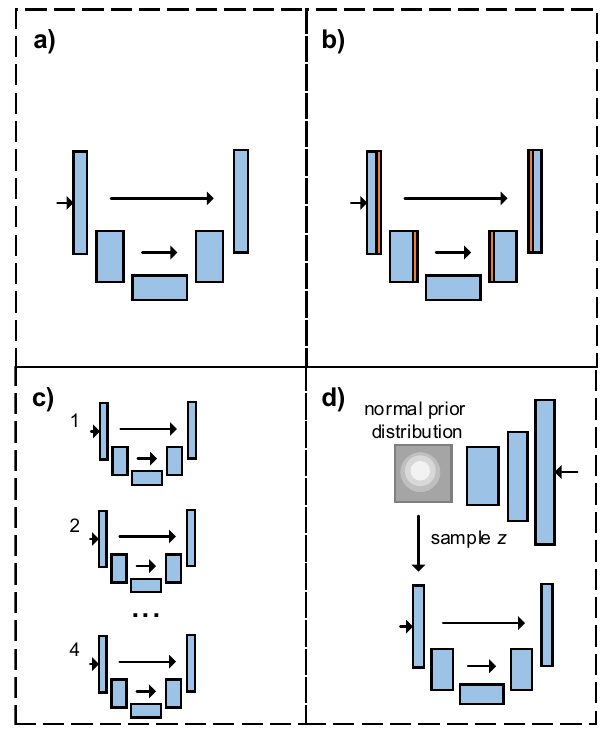
Fig. 4 Schematic overview of the four evaluated models. In a – d the U-Net with softmax output, the MC dropout U-Net, the ensemble of U-Nets, and the probabilistic U-Net. The feature maps are visual- ized in blue, the dropout layers in orange. The Figure was adapted from [17] and [18]